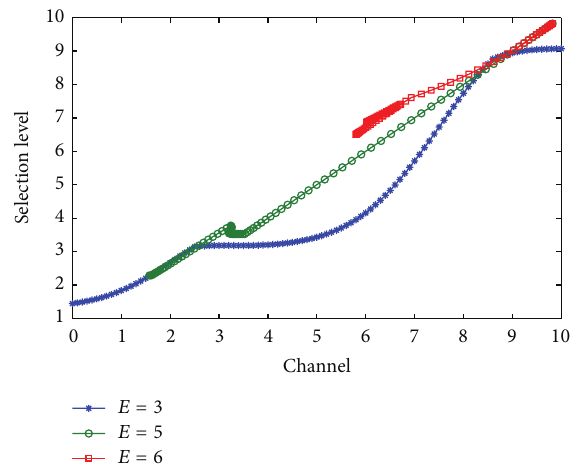
Figure 5: Effect of 𝐸 = 3 , 𝐸 = 5 , and 𝐸 = 6 on the selection level for coordinator in face of jam attack.